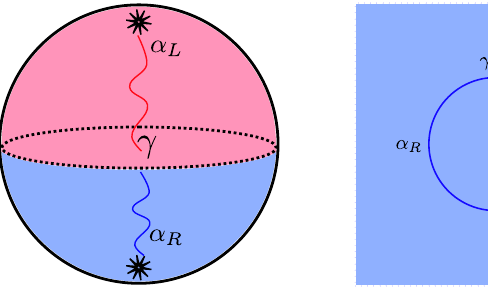
channel. (Middle) R (cid:13) . We are suppressing a red